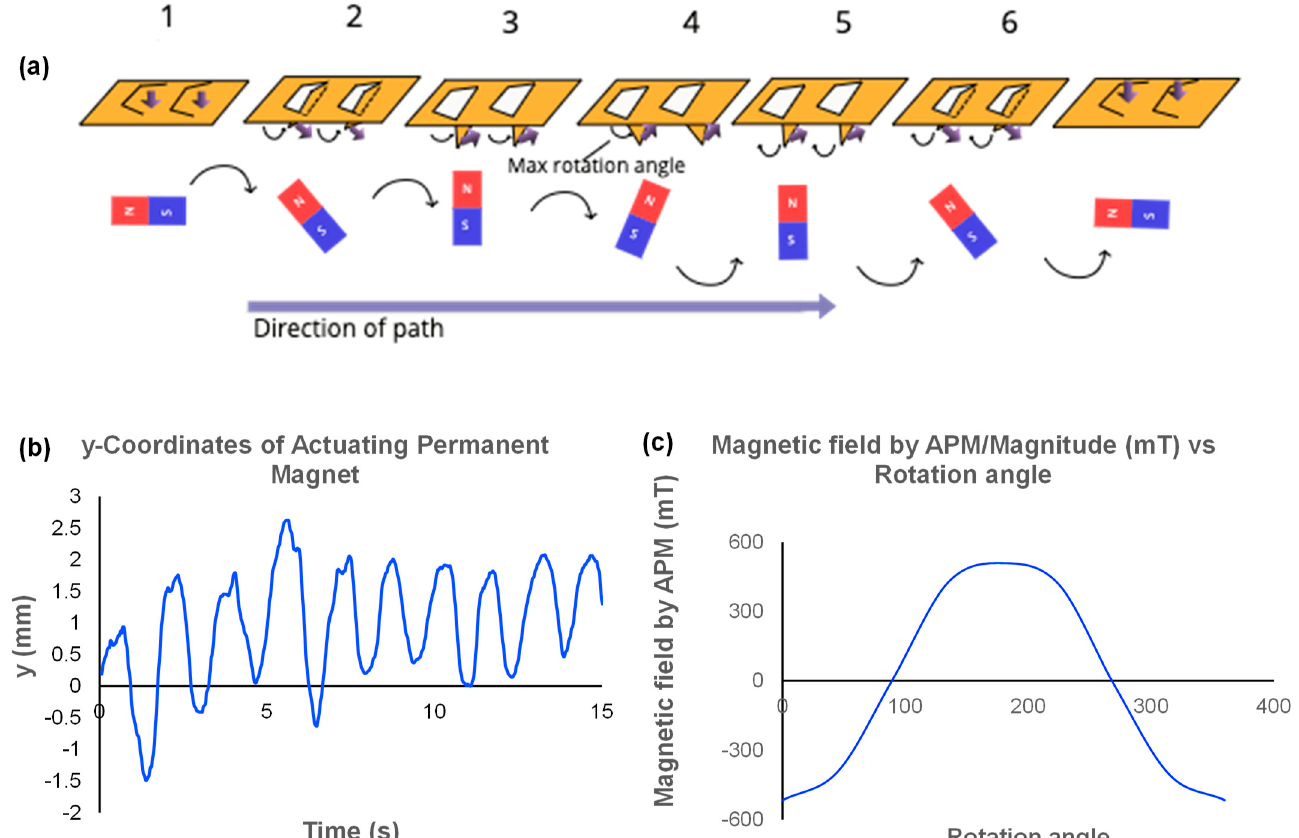
Figure 6. Locomotion mechanism presented in this paper: ( a ) Basic locomotion mechanism using an APM, split into six phases. The mechanism base has trapezoidal flaps attached with internal permanent magnets (IPM) with the direction of magnetization indicated by the purple arrows. Rotation of APM triggers the IPM (and consequently the trapezoidal flaps) to rotate, propelling the mechanism forward. ( b ) Sinusoidal representation of the movement of actuating magnet at approximately 0.6 Hz. ( c ) Magnetic field strength B (mT) of APM measured against rotation angle of the APM, in which the rotation angle is set to be the vertical direction with the north pole facing the